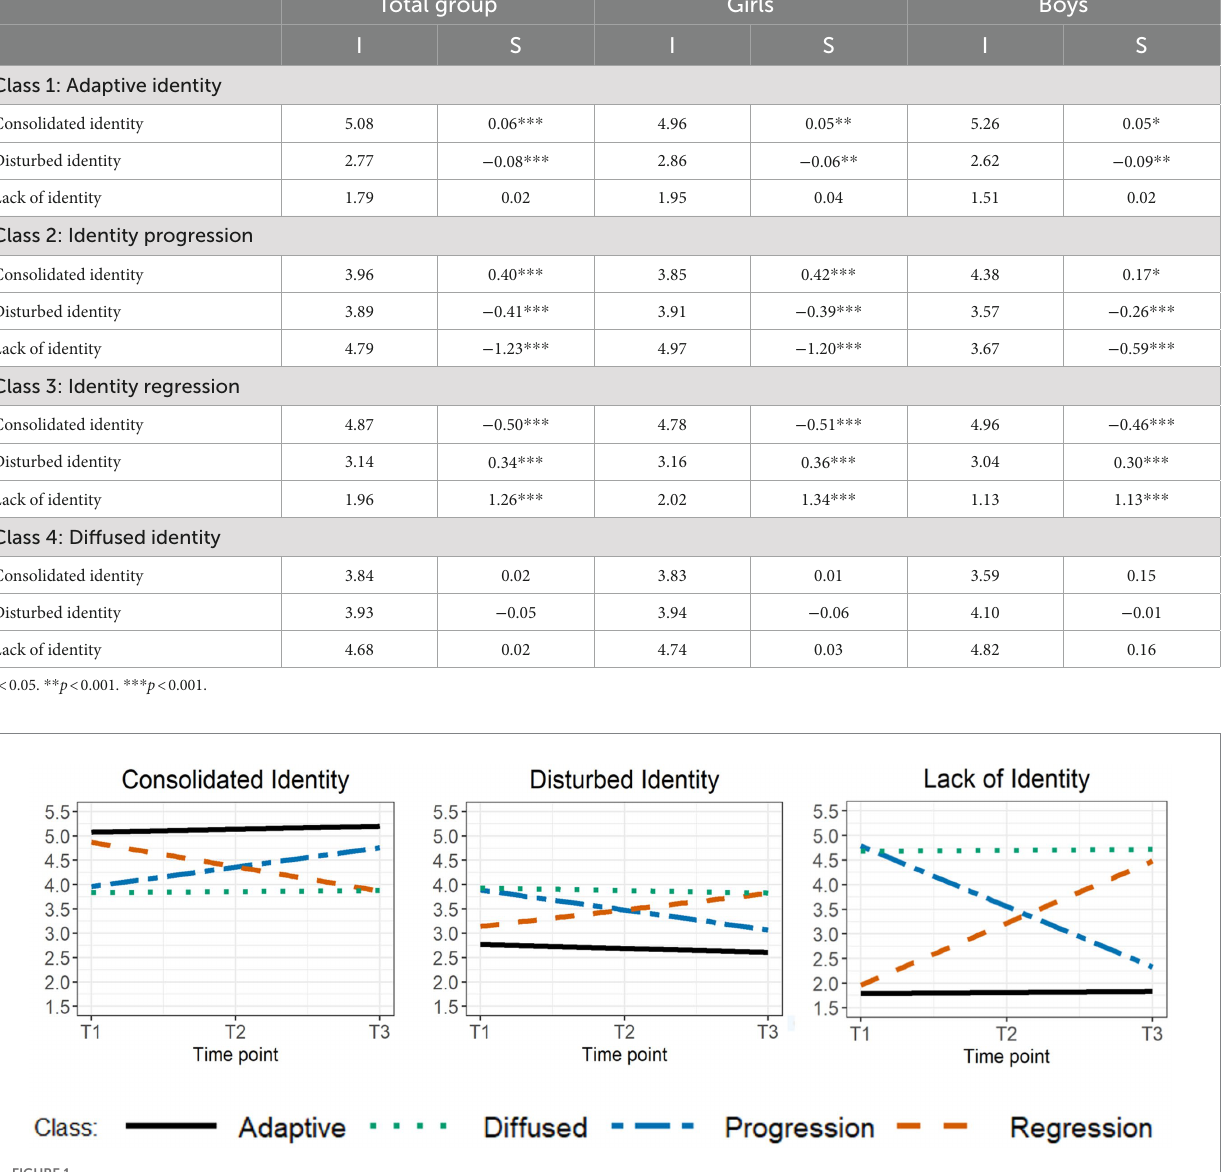
FIGURE 1 Mean intercepts and slopes for the identity dimensions in the four-class